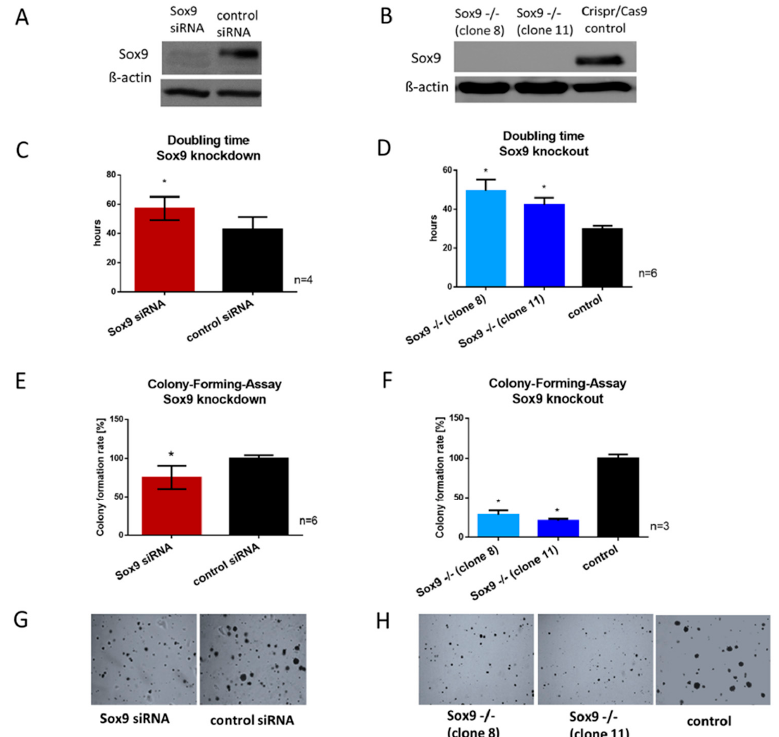
Figure 2. Proliferation and colony-forming ability after Sox9 knockout and knockdown in HTB94 chondrosarcoma cells. ( A ) Representative Western blot images of SOX9 after siRNA-mediated SOX9 knockdown and Crispr / Cas9-mediated SOX9 knockout ( B ). ( C , D ) SOX9 knockdown and knockout cells revealed an increase in doubling time and ( E , F ) a decrease in the ability to form colonies from single cells cultured in agarose. ( G , H ) Representative images of colony formation after SOX9 knockdown and knockout (Magnification 10 × ). Results are the means ± SD; * p ≤